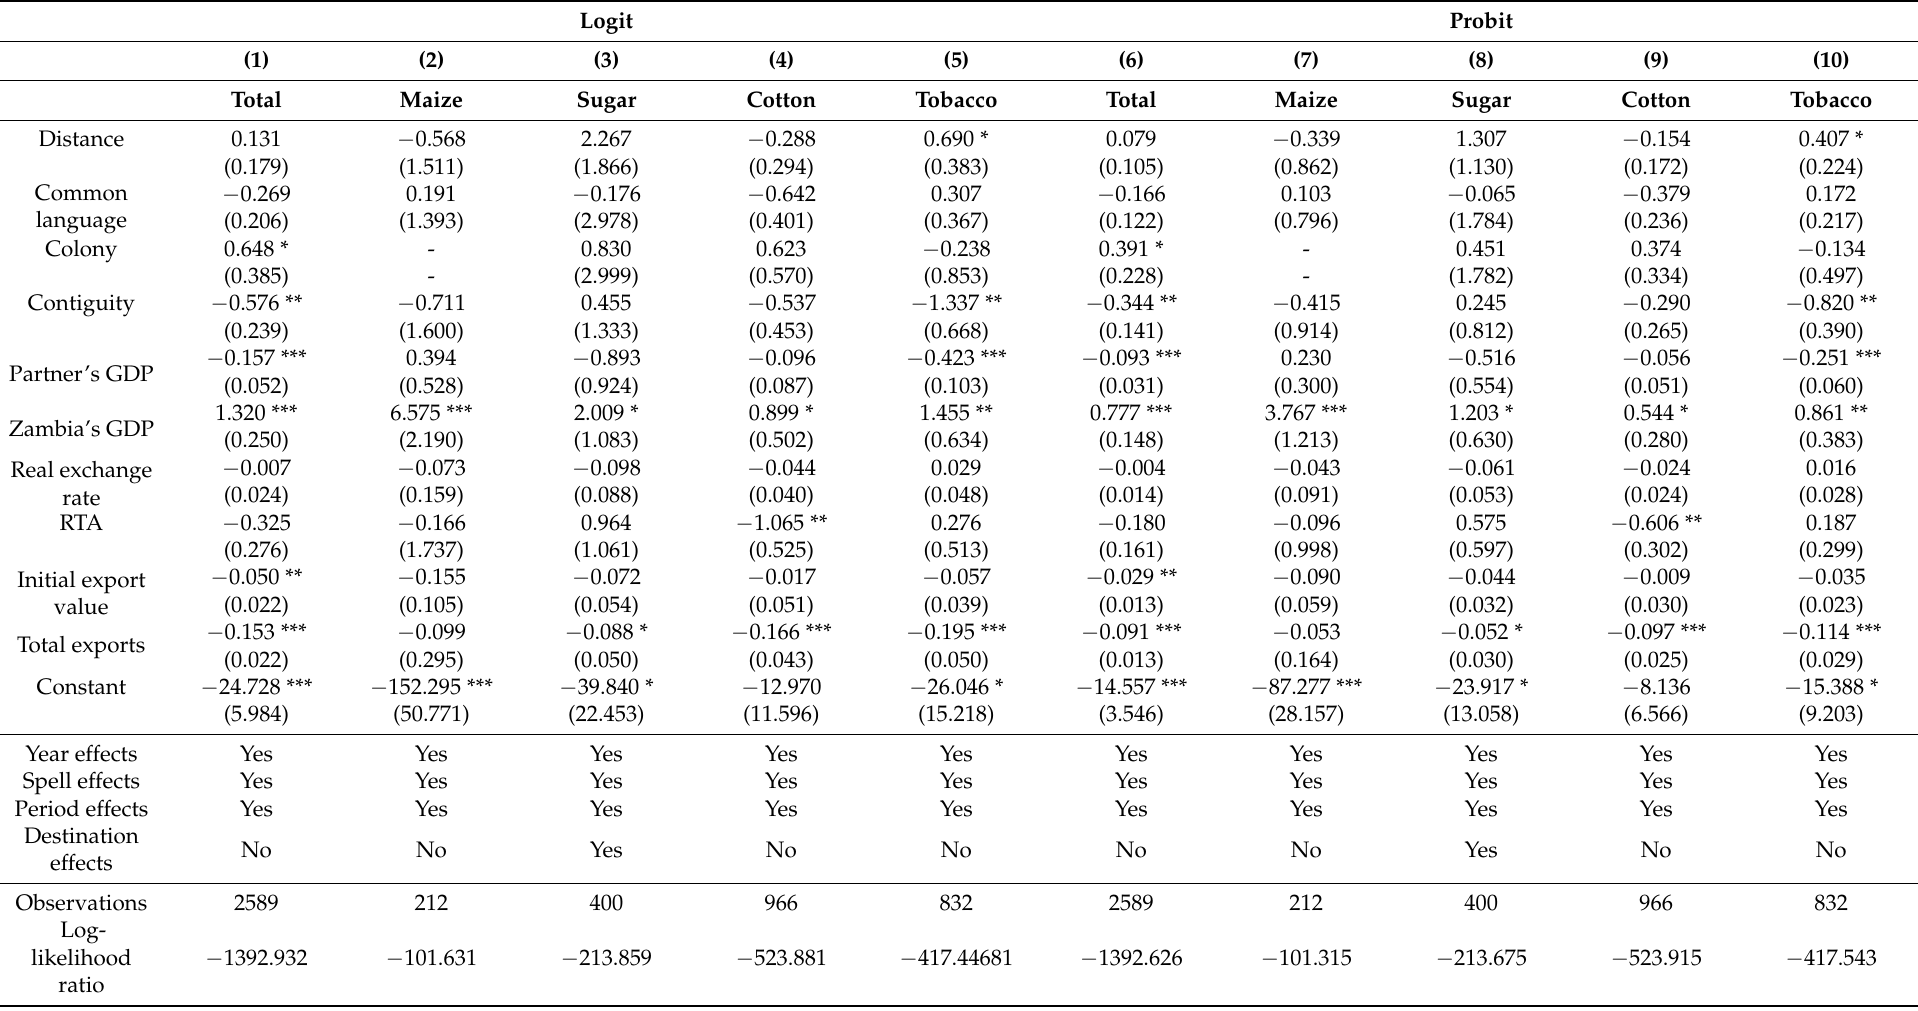
Table 2. Regression results for agricultural products (total and categories). GDP, gross domestic product; RTA, Regional Trade